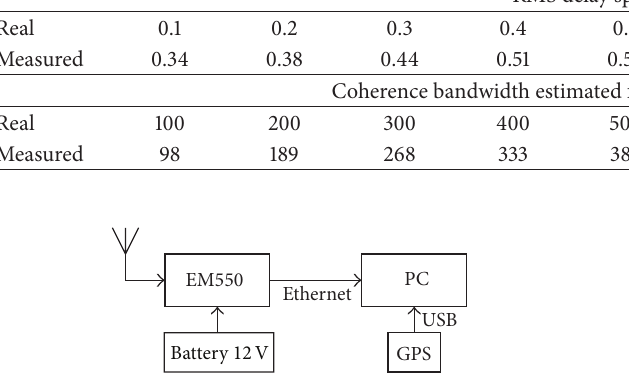
Figure 3: Block diagram of mobile measurement set for CDMA- 2000 signals